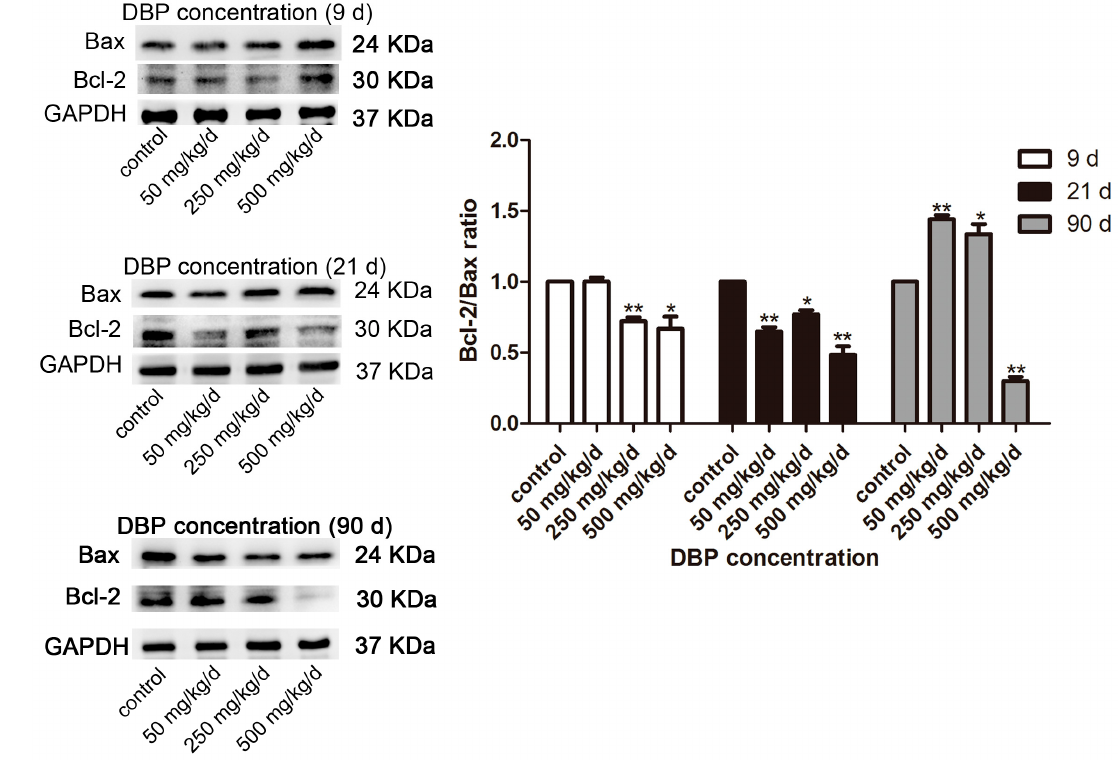
Figure 3. DBP induces the activation of pro-apoptosis protein in testicular tissue. The protein levels of Bax and Bcl-2 in testicular tissue treated with various concentration of DBP were measured by Western blot. The expression levels were quantified with ImageJ (right panel; n = 3). Glyceraldehyde-3-phosphate dehydrogenase (GAPDH) was run as an internal control. Results are expressed as means ± S.D. ** p < 0.01; * p < 0.05.